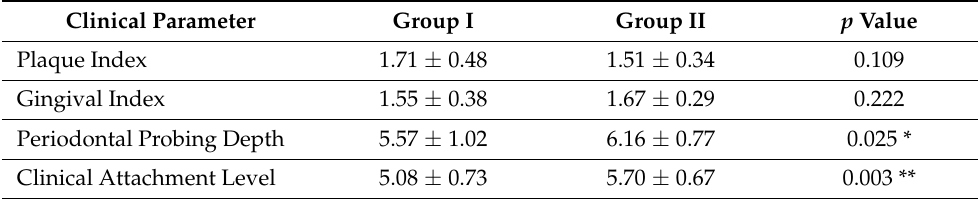
Table 2. Comparative analysis of clinical parameters among the study